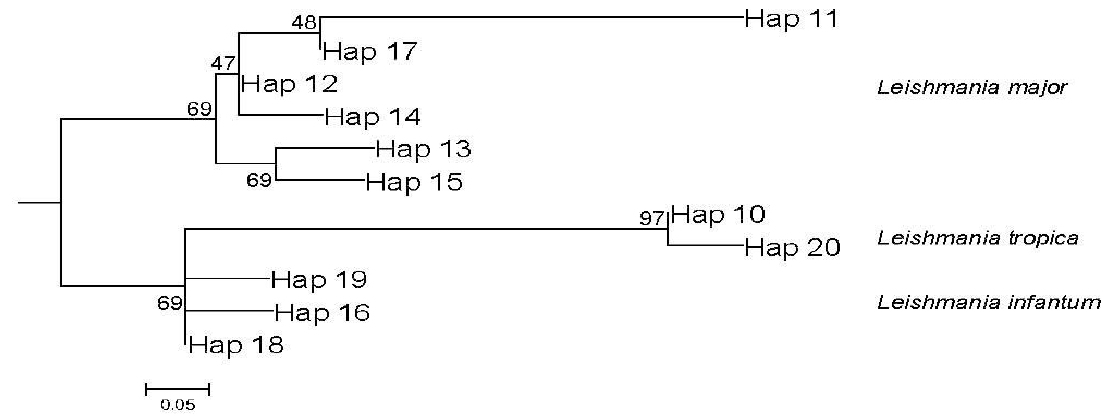
Figure 6. Maximum-likelihood phylogenetic tree for 11 haplotypes of all rodent hosts– Leishmania parasites based on ITS1-rDNA gene sequences. Sequences fitting for each haplotype are defined in Supplementary Table S3. Haplotypes are numbered from 10 to 20 to avoid confusion with the previous figure. The numbers above the branches are bootstrap percentages of 1000 replications.